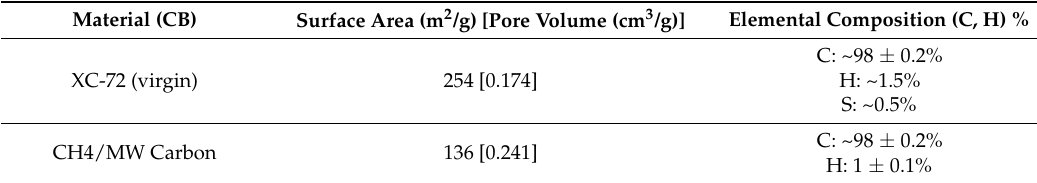
Table 2. Physical and compositional properties of carbon